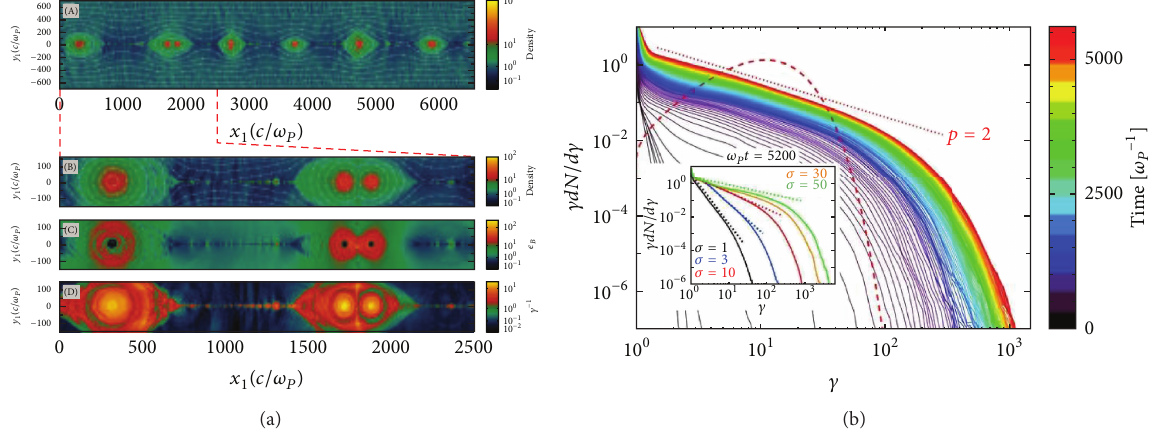
Figure 16: Results of an electromagnetic particle in cell (PIC) simulation TRISTAN-MP show the structure of the reconnection layer (a) and the accelerated particle distribution function (b). (a) Structure of the reconnection layer. Shown are the particle densities (A), (B), magnetic energy fraction (C), and mean kinetic energy per particle (D). The plasmoids are clearly seen. (b) Temporal evolution of particle energy spectrum. The spectrum at late times resembles a power law with slope 𝑝 = 2 (dotted red line) and is clearly departed from a Maxwellian. The dependence of the spectrum on the magnetization is shown in the inset. Figure is taken from Sironi and Spitkovsky